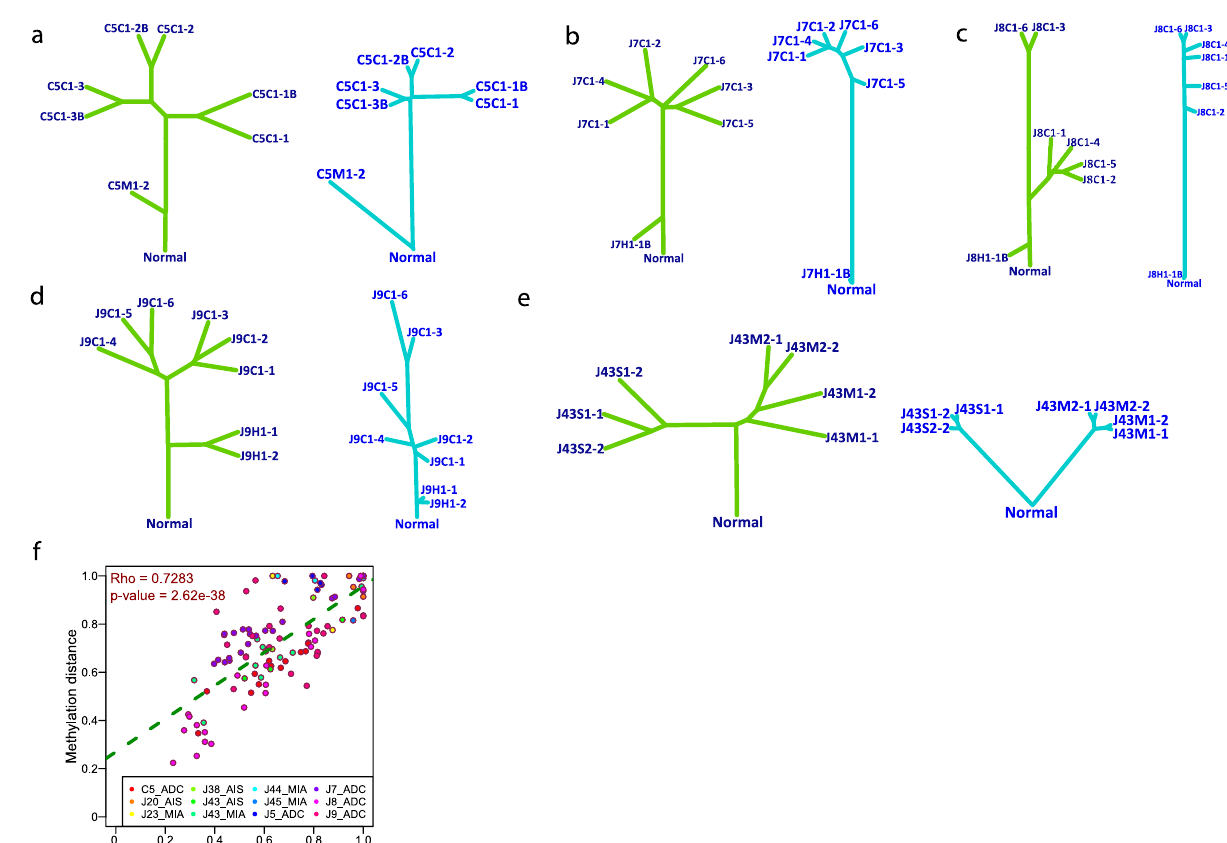
Fig. 5 The evolutionary relationship between genomic and methylation landscape. Phylogenetic trees based on mutations (blue) and methylation values (green) in patient C5 ( a ), J7 ( b ), J8 ( c ), J9 ( d ), and J43 ( e ). The length of each branch indicates the similarity of mutation or methylation pro fi les between any pair of two spatially separated specimens from each patient. To avoid over fi tting, only patients with IPNs having a minimum of four spatially separated specimens were included for this analysis. f Correlation of genetic distance (Hamming distance based on all mutations) and methylation distance (Euclidean distance based on methylation values of all CpG sites) between different spatially separated specimens from the same IPNs assessed by two- tailed Spearman ’ s correlation analysis ( p = 2.62 × 10 − 38 ). Each dot represents the normalized distance between each pair of specimens from the same IPNs. Source data is provided as a source data fi